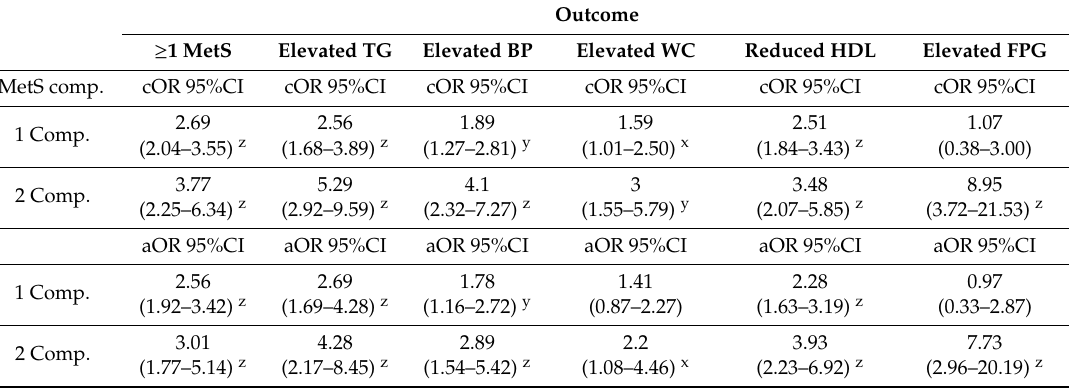
Table A2. OR of outcome according to the number of components based on the Harmonized Criteria in normoweight young adults. Outcome ≥ 1 MetS Elevated TG Elevated BP Elevated WC Reduced HDL Elevated FPG MetS